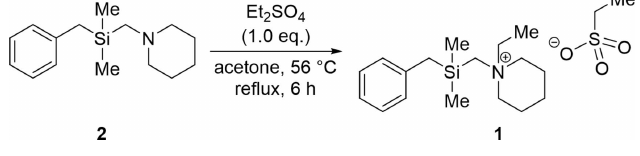
Figure 5 Reaction scheme of the alkylation of 2 with diethyl sulfate for the synthesis of 1